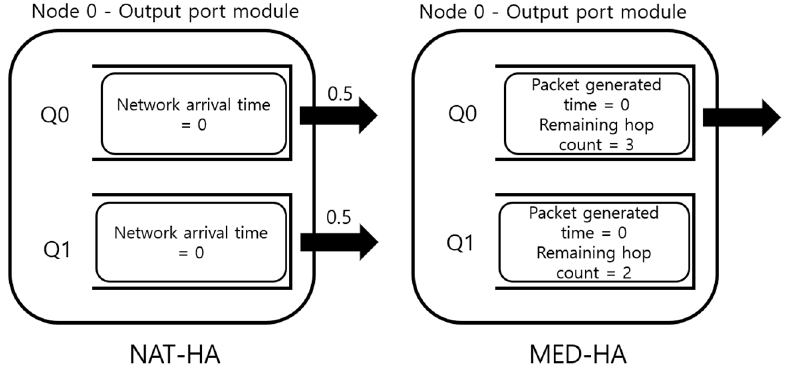
Figure 6. In the example topology, when packets want to go out simultaneously from node 0 at time 0, the service of each heuristic algorithm is displayed.